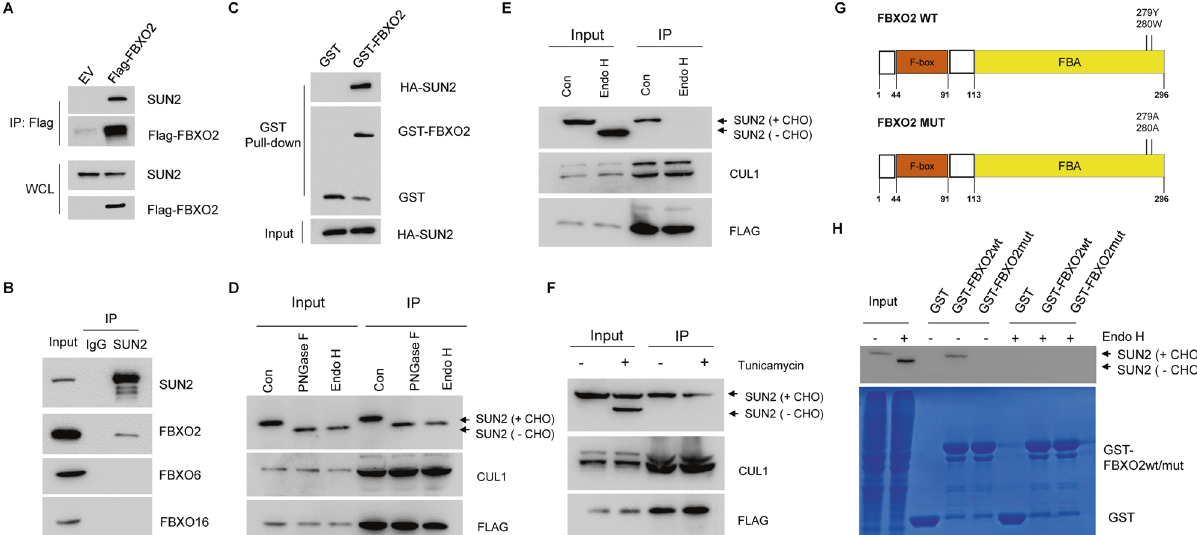
Fig. 4 FBXO2 interacted with glycosylated SUN2 protein. A HEK293T cells were transfected with FLAG-Con or Flag-SUN2 for 36 h. MG132 was added 4 h before harvest. Cells were lysed and immunoprecipitated with Flag M2 beads. The beads-associated proteins were eluted by Flag peptide and subjected to immunoblot with anti-FLAG or anti-SUN2 antibodies, respectively. B The cell lysates of A2780 cells were subjected to immunoprecipitation with IgG or anti- SUN2 antibody and then detected by immunoblotting with indicated antibodies. C The HEK293T cells transfected with HA-SUN2 were lysed and then incubated with GST alone or GST-FBXO2 immobilized on GST-Sepharose beads. The bound protein was eluted with SDS loading buffer and detected by immunoblotting with indicated antibodies. D Lysates and immunocomplex from A2780 cells expressing FLAG-FBXO2 were treated with or without either Endo H or PNGase F for 1 h at 37 °C Samples were analyzed by immunoblotting with the indicated antibodies. CHO, carbohydrate oligosaccharide. E Lysates from A2780 cells expressing FLAG-FBXO2 were treated with ( + ) or without ( − ) Endo H at 37 °C for 1 h, and then were immunoprecipitated with anti-FLAG antibody and detected by immunoblotting with indicated antibodies. F A2780 cells expressing FLAG-FBXO2 were treated with ( + ) or without ( − ) 10 μ g/mL tunicamycin for 36 h, lysates were immunoprecipitated with anti-FLAG antibody and detected by immunoblotting with indicated antibodies. G The diagram of FBXO2 WT and FBXO2 MUT proteins. Brown box indicates the F-box domain, yellow box indicates the FBA domain. H The HEK293T cells transfected with HA-SUN2 were treated with ( + ) or without ( − ) 10 μ g/mL tunicamycin for 36 h. The cell lysates were incubated with GST alone or GST-FBXO2 (WT or Mut) immobilized on GST-Sepharose beads. The bound proteins were eluted with SDS loading buffer and detected by immunoblotting with indicated